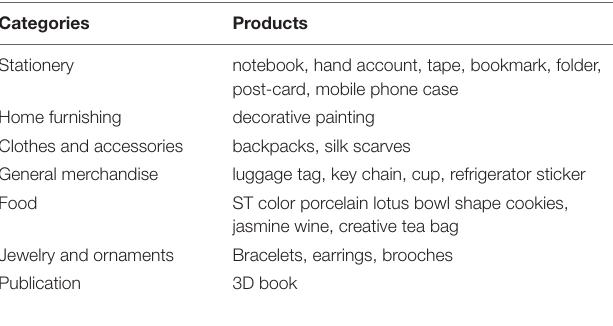
TABLE 2 | Cultural and creative products sold online in Suzhou